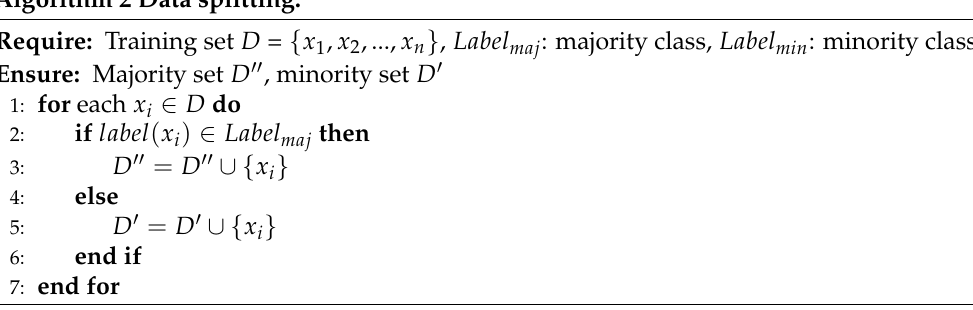
Algorithm 2 Data splitting.